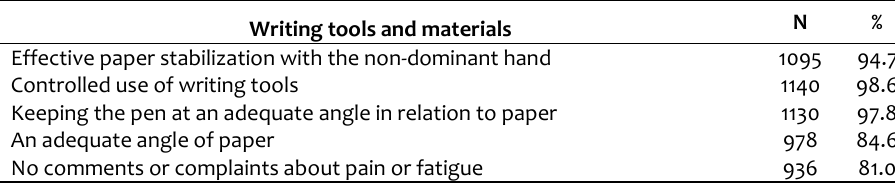
Table 1. Frequency of use of writing tools and